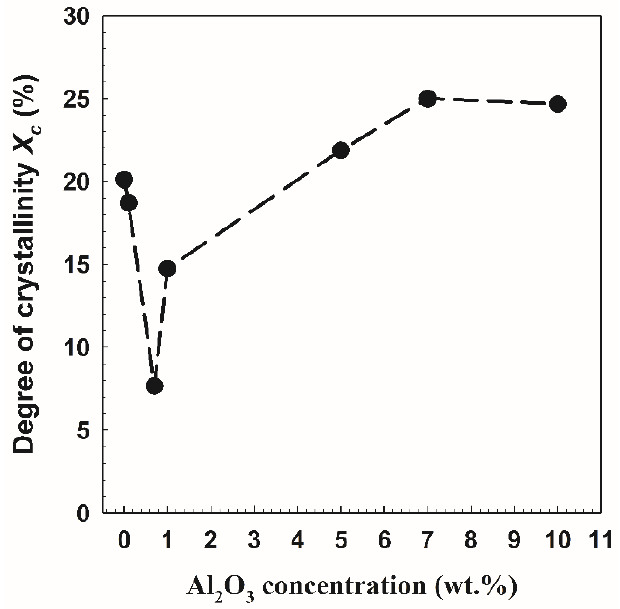
Figure 4. The degree of crystallinity as a function of Al 2 O 3 contents in PVA/10 wt.% PEG/20 wt.% SSA membranes.